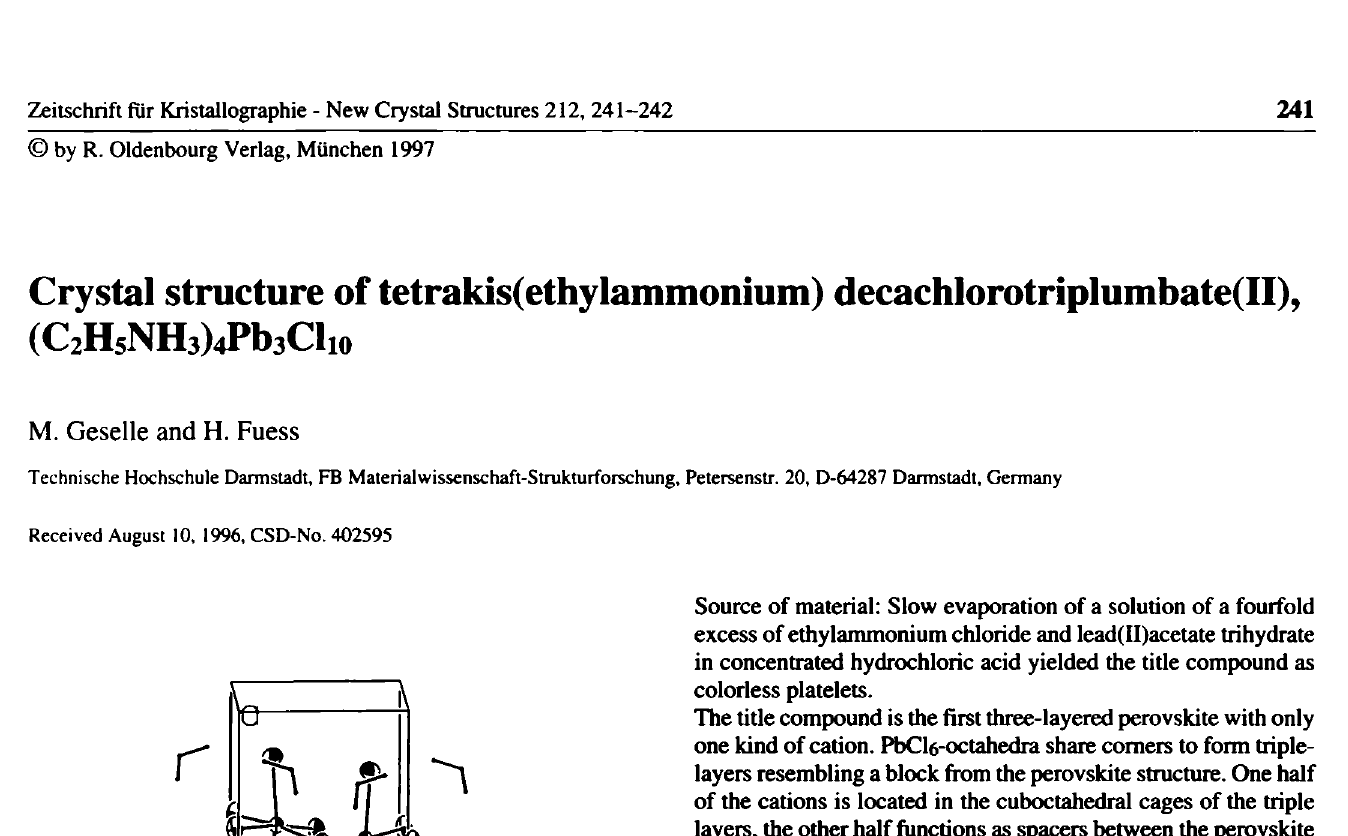
Table 1. Parameters used for the X-ray data collection Crystal: